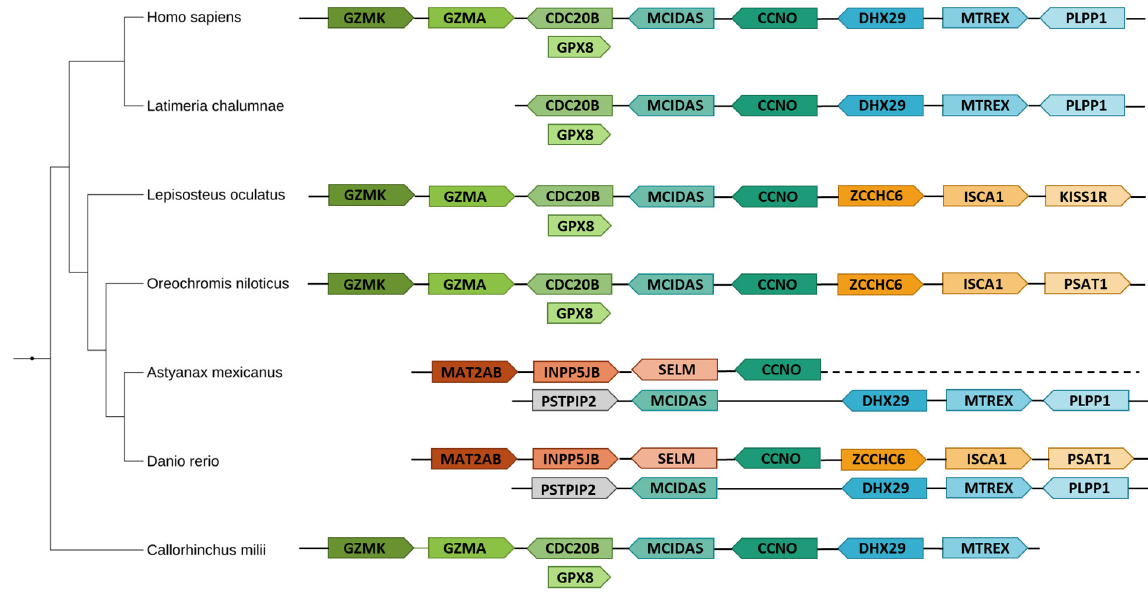
Figure 6. Multiciliated locus in selected vertebrate species. The locus contains MCIDAS , CCNO and CDC20B , three genes essential for multiciliation. This synteny block is conserved in most vertebrate species except in Otomorpha fish ( Danio rerio, Astyanax mexicanus